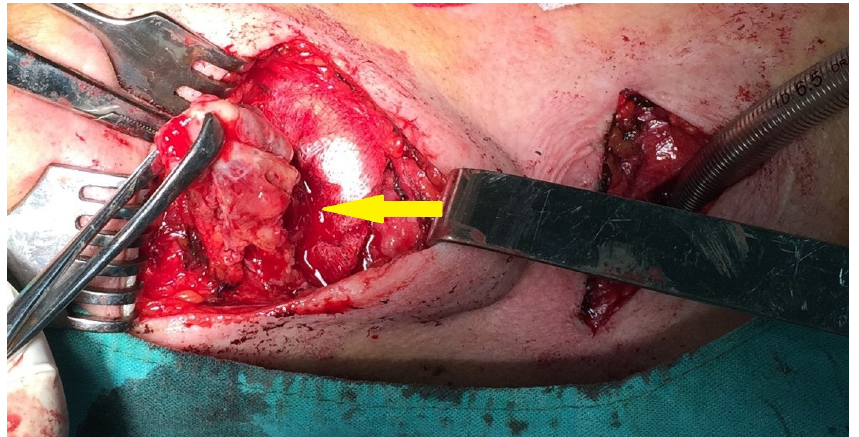
Figure 3. Intraoperatory imaging (Arrow—Tumor).